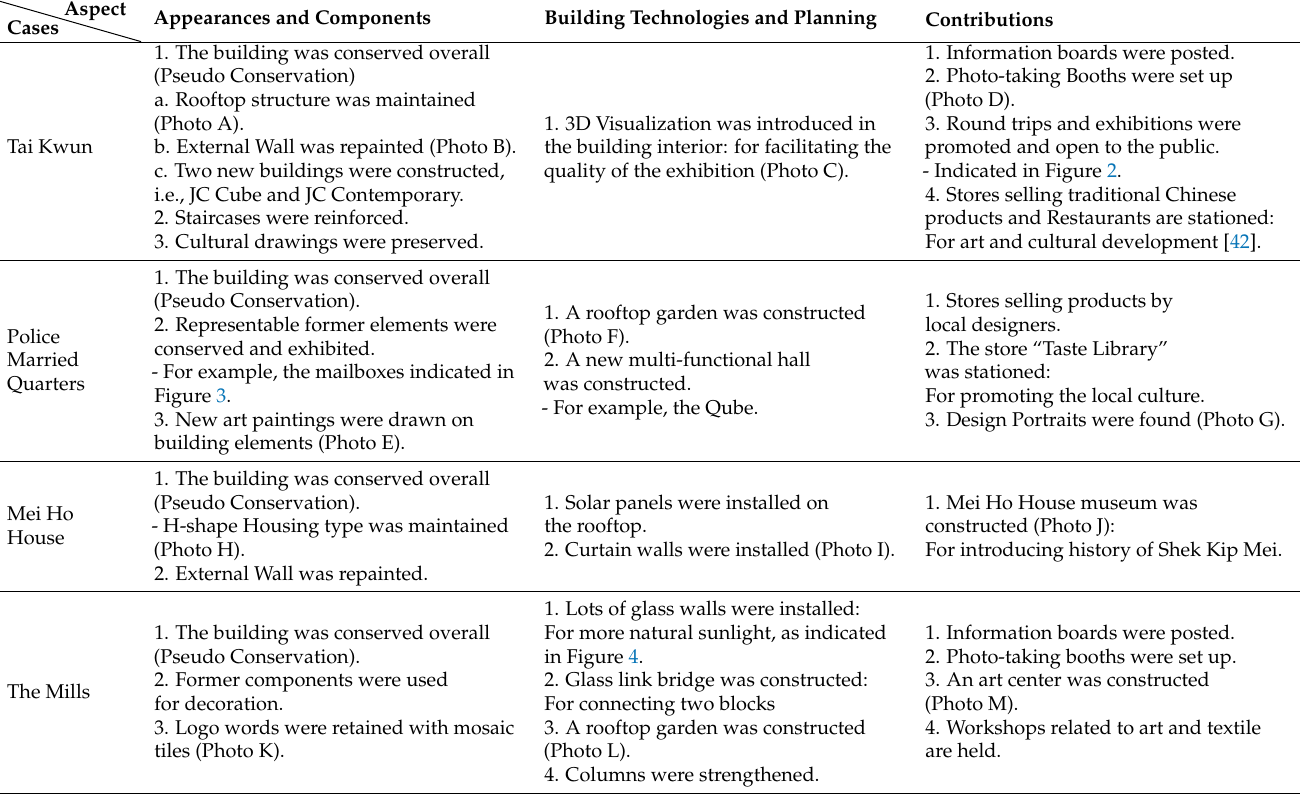
Figure 4. Lots of glass walls installed for more natural sunlight.